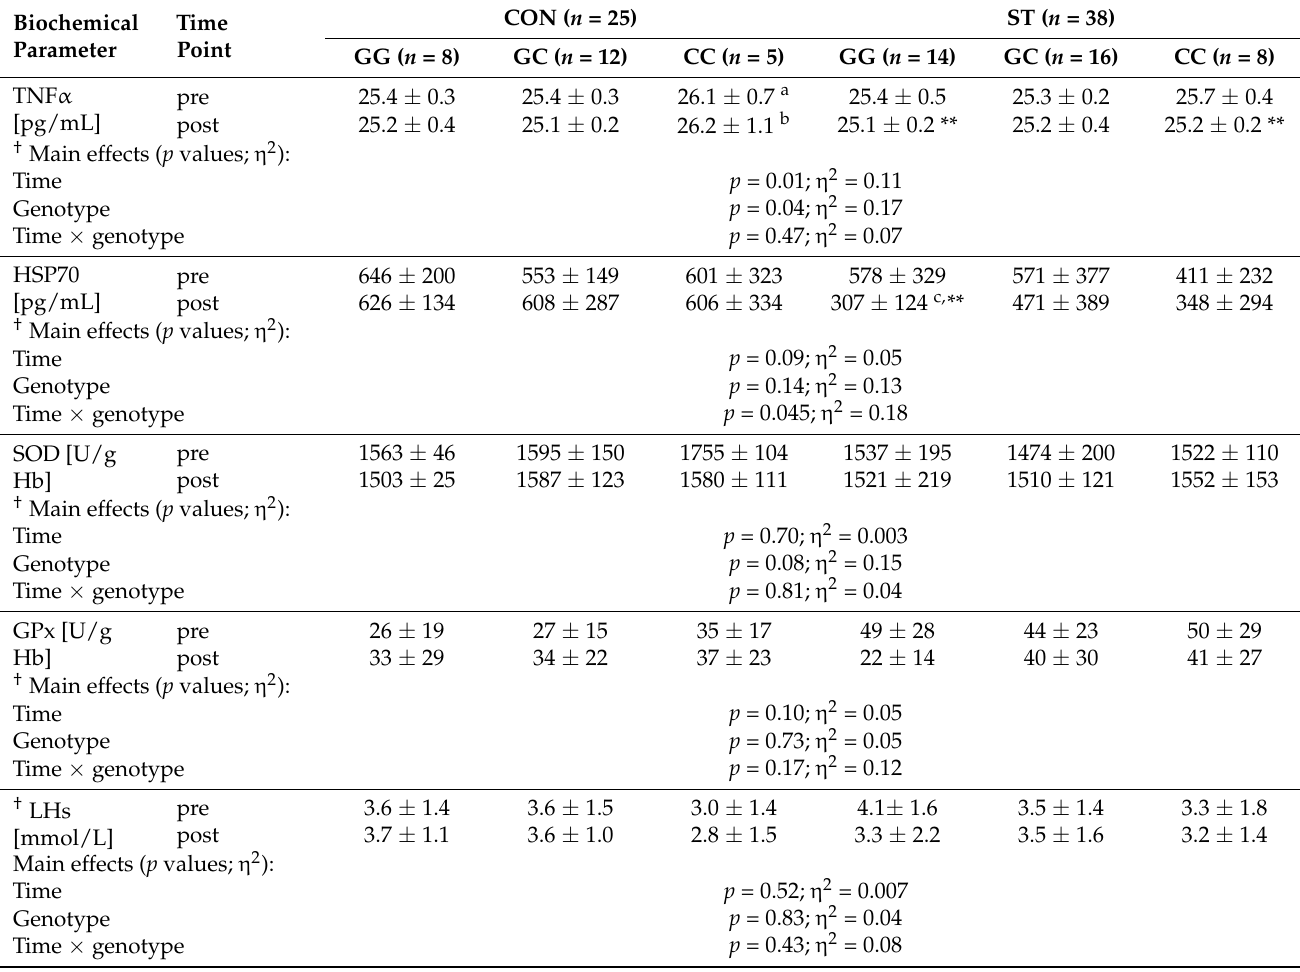
Table 4. Biochemical parameters in blood prior to (pre) and after (post) 12-week in the control (CON) and swimming training (ST) group; the results stratified according to IL-6 gene